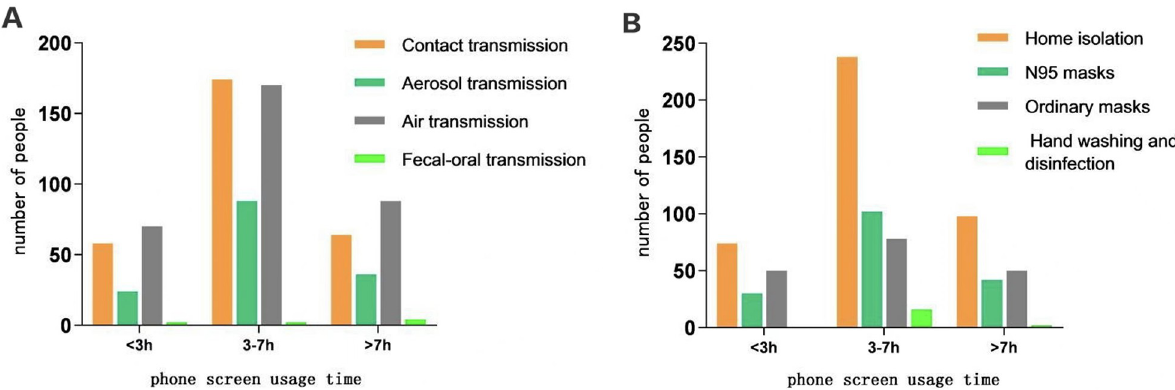
Fig 1. Comparison of college students’ cognition of the epidemic situation by different mobile phone screen usage time. (a)College students’ knowledge of the transmission route of the epidemic at different time online; (b) College students’ knowledge of epidemic prevention and control measures in different time online.